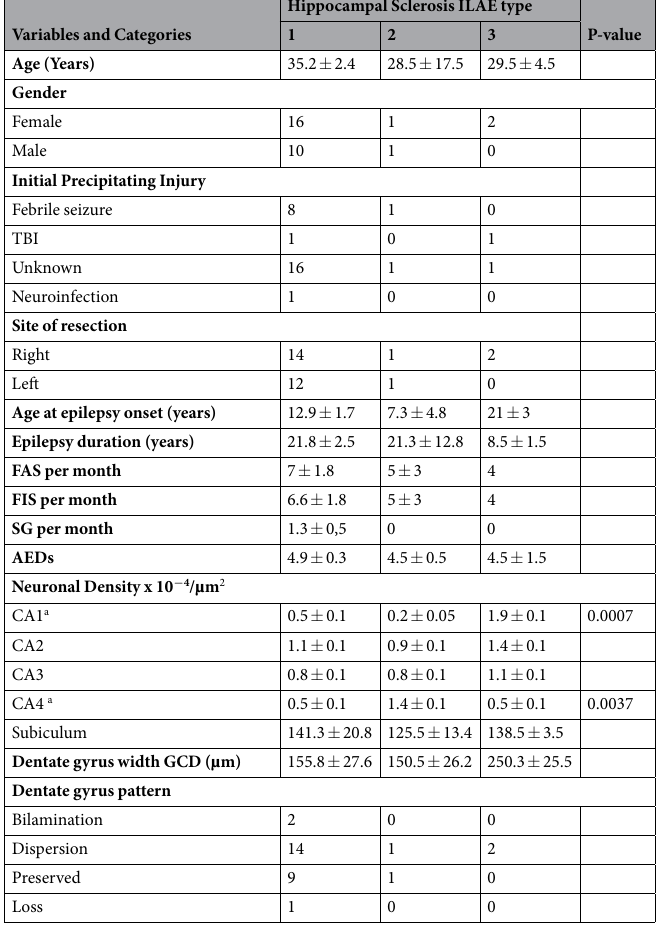
Table 2. Clinical and histopathological information of patients with pharmacoresistant temporal lobe epilepsy. TBI: traumatic brain injury; FAS: focal aware seizure; FIS: focal impaired awareness seizure; GS: generalized seizure; AEDs: antiepileptic drugs; GCD; granular cell dispersion. Data from histology is presented as neuronal densities × 10 − 4 / µ m 2 . All data are expressed as the mean ± SEM. a P-values are indicated when significant difference for group were observed using Kruskal-Wallis H